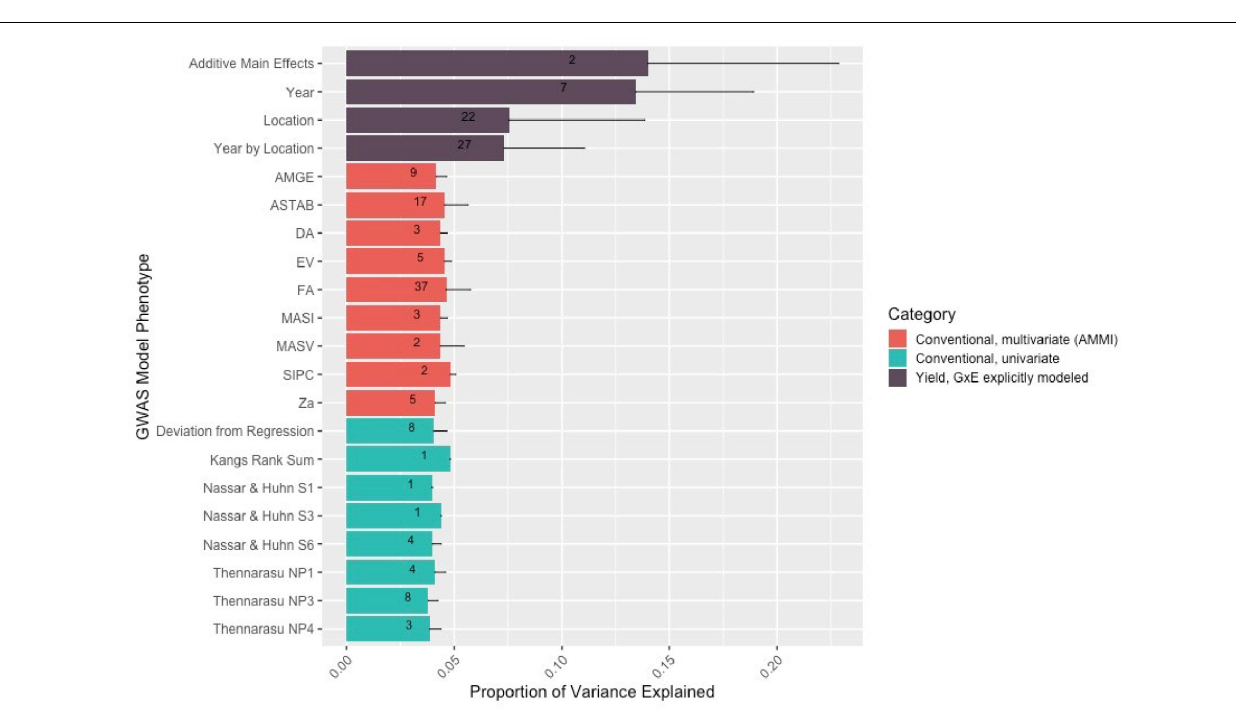
FIGURE 3 | The number and variance explained by the QTL discovered in the explicit GxE model is greater than that discovered by GWAS models using either type of conventional measurement as a phenotype. Numbers within the bars represent the number of QTL discovered for that model/model level. The thin dark line from the top of the bar represents the standard deviation for yield variation explained among the QTL for that